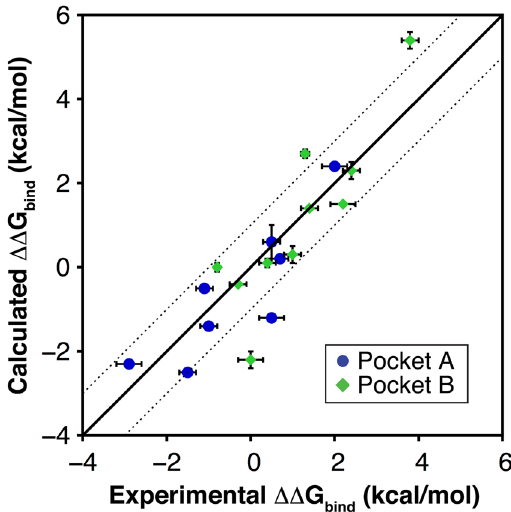
Figure 3. Comparison of calculated and experimental relative binding free energies ( ΔΔ G bind ) for 18 compound pairs. The solid line represents prefect agreement between calculated and experimental data whereas the dotted lines represent an absolute deviation of 1 kcal/mol. Experimental and computational error bars correspond to the data reported in Table